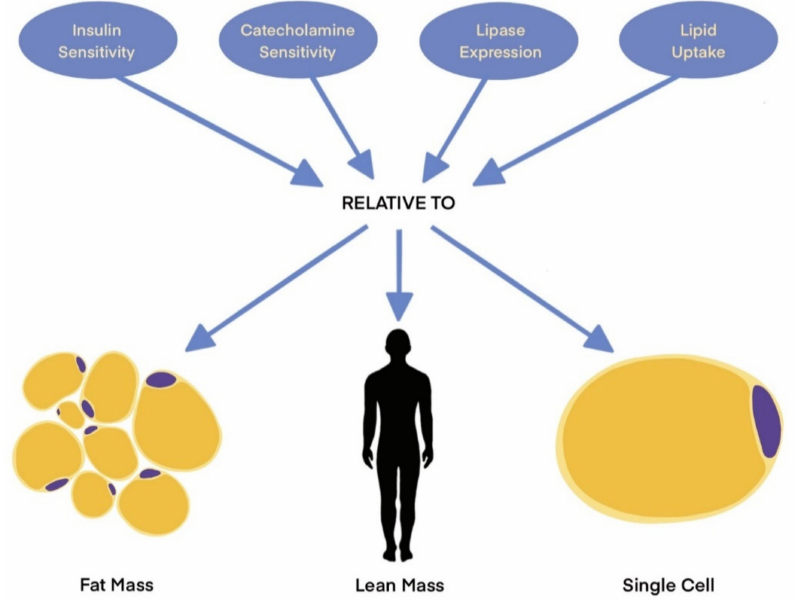
Figure 2. Metabolic variable interpretation is dependent on anatomical context. NEFA secretion, for example, is low relative to fat mass but high relative to lean mass in obese individuals. Imprecise language describing data may lead to